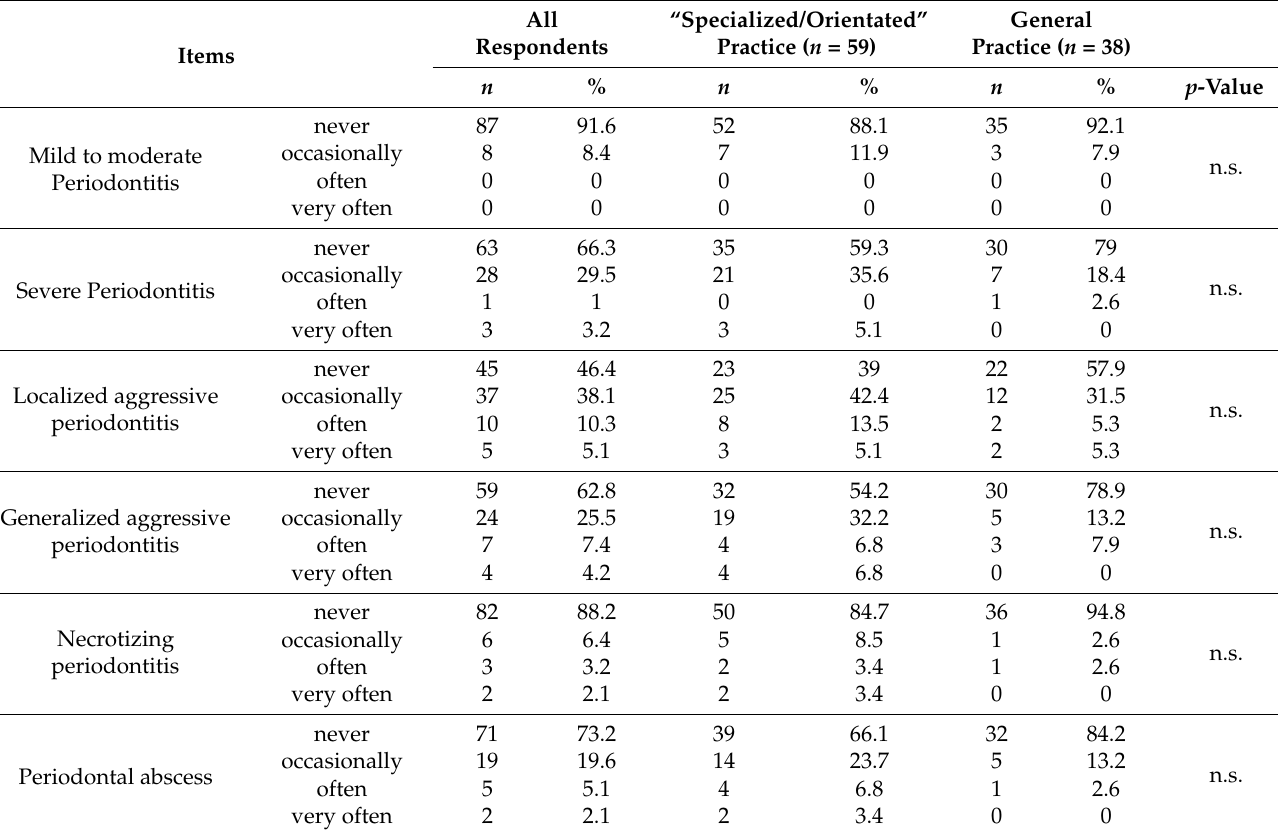
Table 3. Use of local antibiotics in periodontal